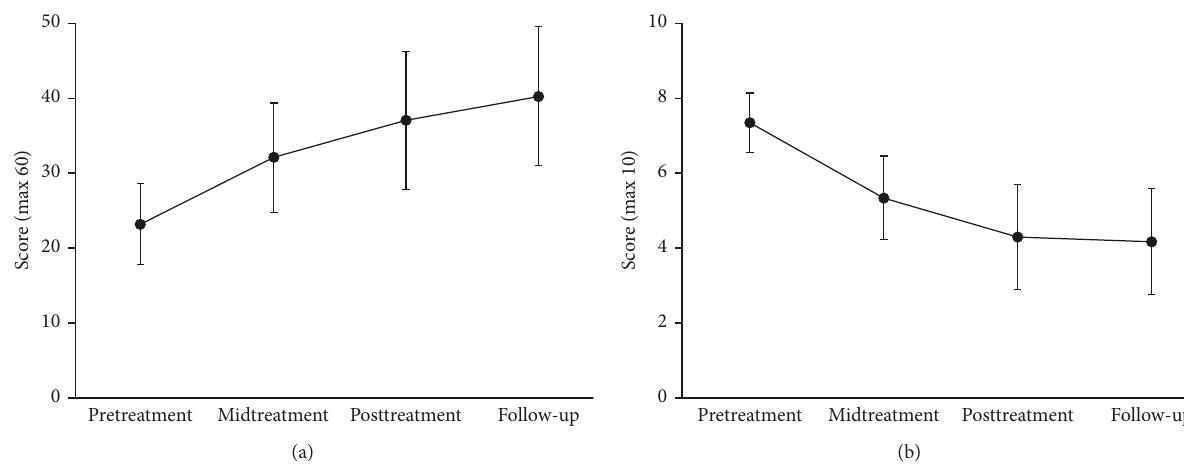
Figure 2: Participant improvement on primary outcome measures. (a) The Pain Self-efficacy Questionnaire (PSEQ), where higher scores indicate greater self-efficacy. (b) The Brief Pain Inventory (BPI)-Interference Score, where lower scores indicate less pain interference. Data are presented as mean and 95% confidence